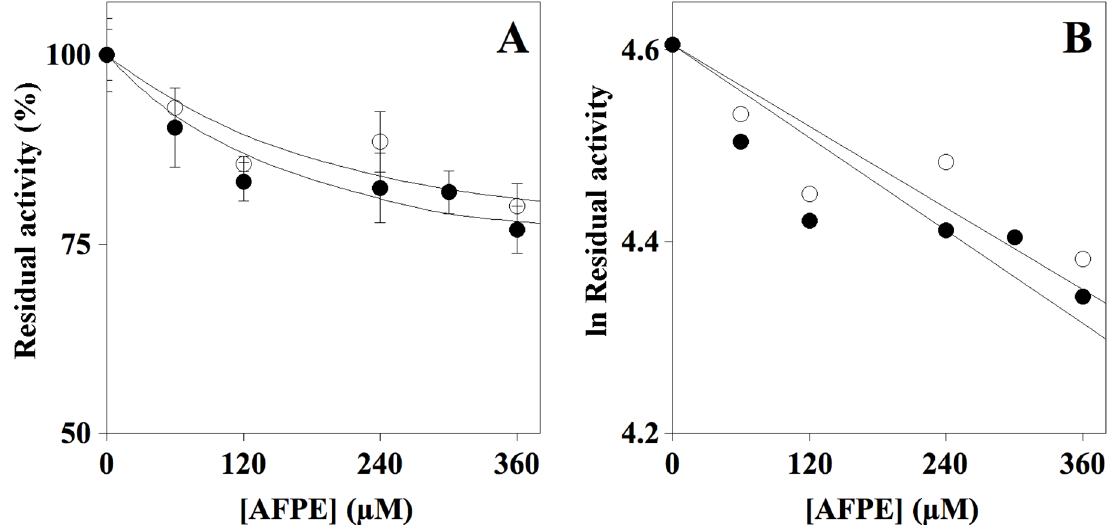
Figure 1. Effect of AFPE on cholinesterase activity. ( A ) AChE (filled circle) or BuChE (empty circle) was assayed in the absence or presence of the indicated amounts of AFPE, as reported in the Methods section. NB. 100 µM AFPE in the reaction mixture corresponded to 23 mg of apple flesh/mL. ( B ) Data were analyzed according to first order behavior, and the IC 50 was calculated from the slope of the linear regression (r 2 , 0.924 for AChE and 0.910 for BuChE).